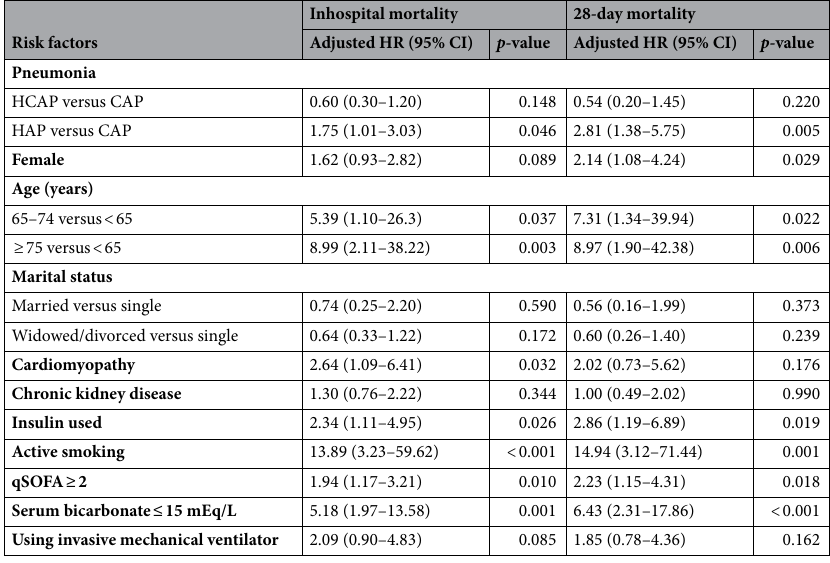
Table 5. Multivariable cox regression analysis for risk factors of inhospital mortality and 28-day mortality. CAP; community-acquired pneumonia, HCAP; healthcare-associated pneumonia, HAP; hospital-acquired pneumonia, qSOFA; quick sequential organ failure